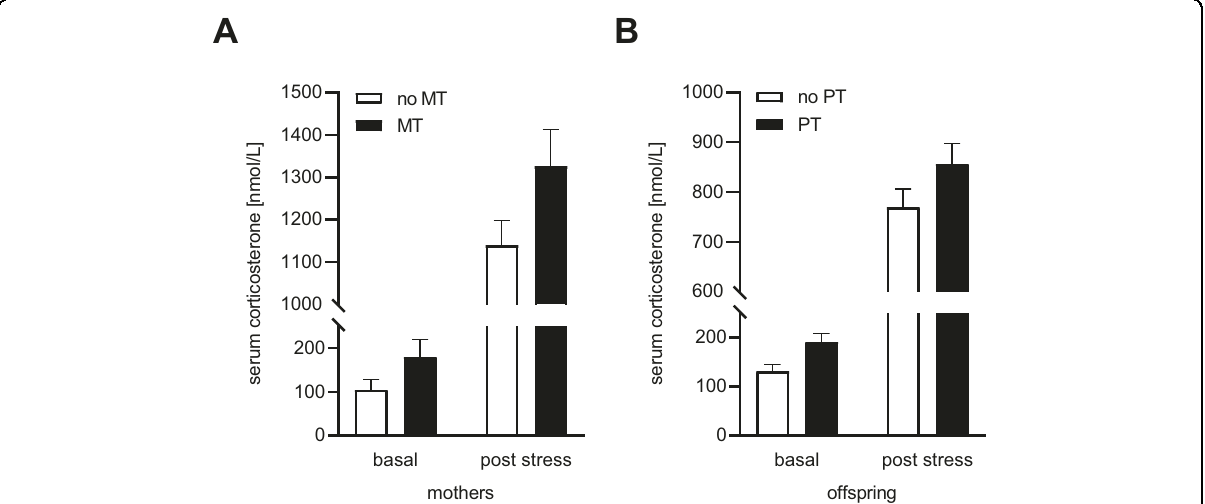
Fig. 2 Serum CORT levels of MT and PT mice before and after stress exposure. A Basal CORT measurement of dams was performed 4 weeks after birth and 7 days before exposure to mild stress. MT dams showed increased basal and post stress CORT levels as compared to control animals. B In PT adult male mice, basal and post stress serum CORT levels were also higher than in no PT mice. See “ Results ” for detailed statistical